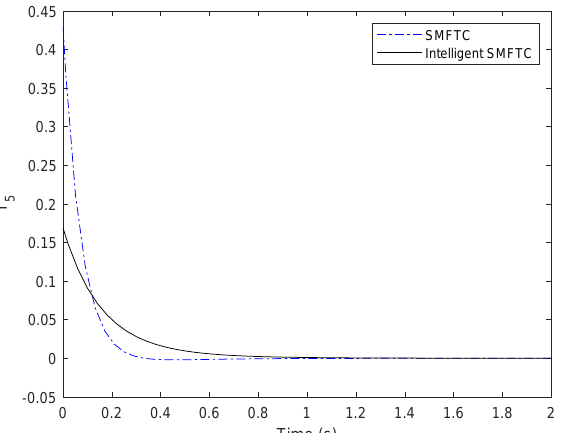
Figure 16. Normalized deviation of total temperature of low-pressure turbine.